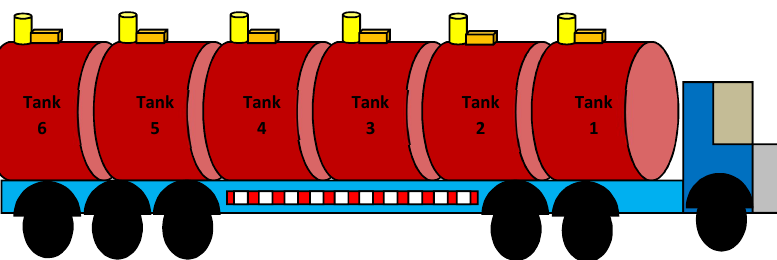
Fig . 1 . A fuel delivery vehicle with multi-compartments